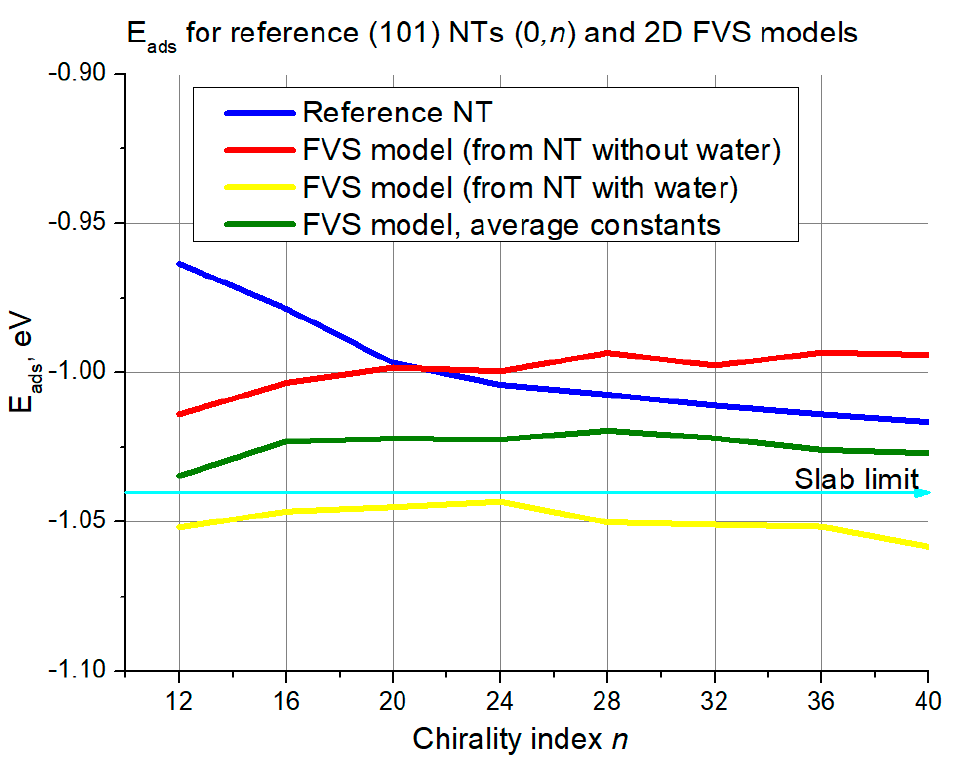
Figure 7. Adsorption energies for (101) NTs (0, n ) and their 2D FVS models. The cyan line with an arrow denotes the slab limit for water adsorption energy.